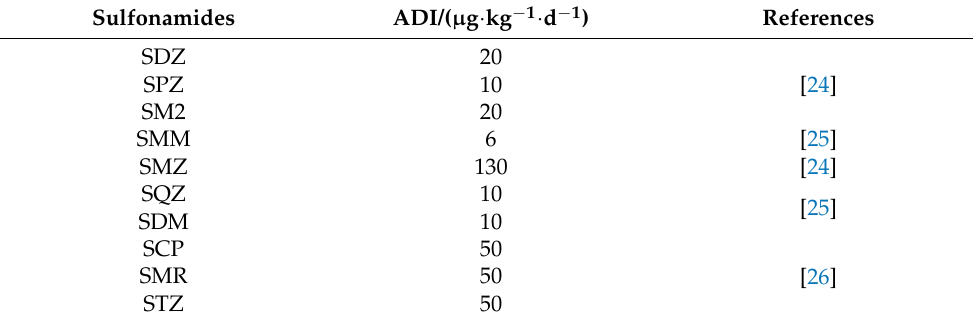
Table 3. ADI values of different sulfonamides.